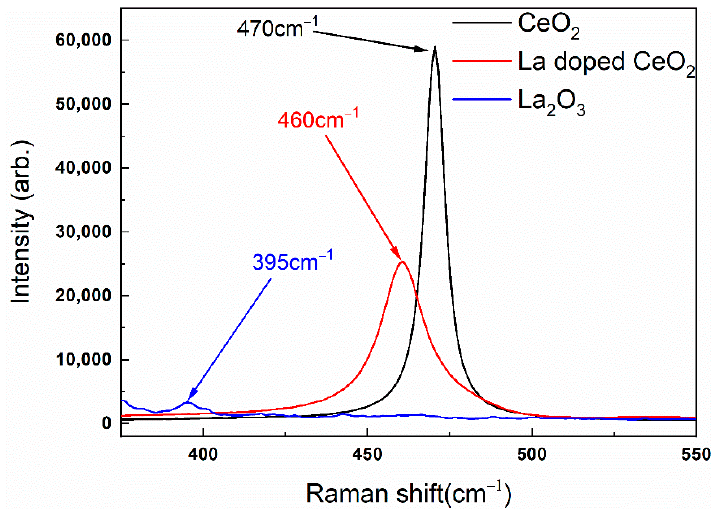
Figure 5. Raman spectrum of CeO 2 (black line), La-doped CeO 2 (red) and La 2 O 3 (blue).